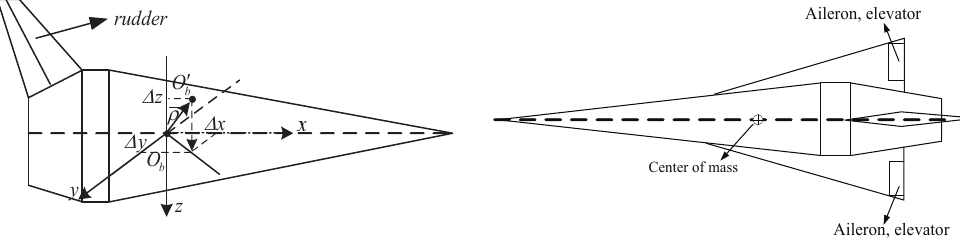
Figure 1. Three-dimensional view of the displacement of the center of mass, O b → O (cid:48)